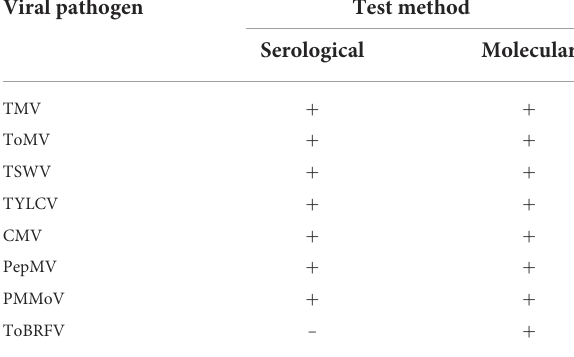
TABLE 1 Viral pathogens tested by serological and molecular methods in tomato